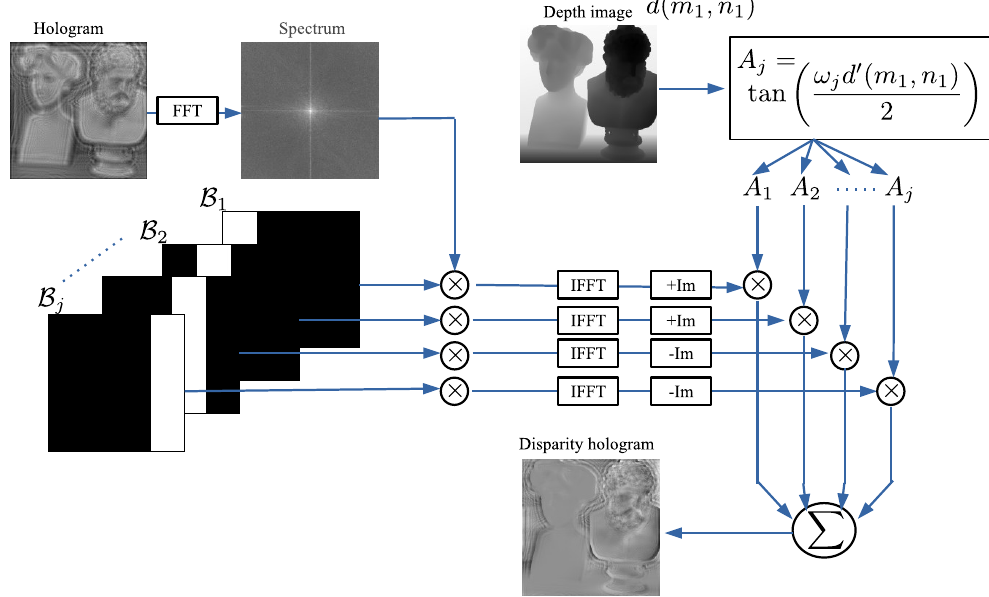
Figure 2. Generation of a disparity hologram. “+Im” and “-Im” take the imaginary part of the IFFT and then multiply the result with ± 1,